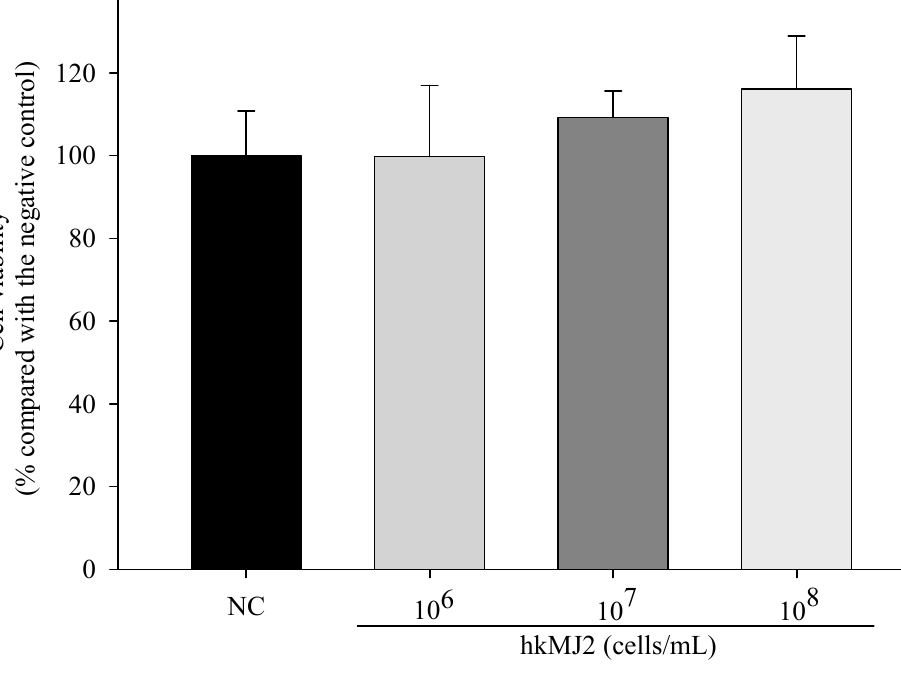
Figure 1. Cytotoxic effect of heat-killed P. freudenreichii MJ2 (hkMJ2) on hFOB 1.19 cells. The values indicate the mean ± SD of three independent experiments performed in triplicate.